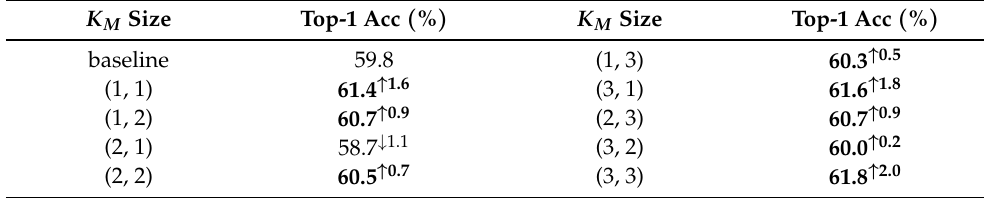
Table 2. Comparison of Top-1 Acc with different settings of the K M